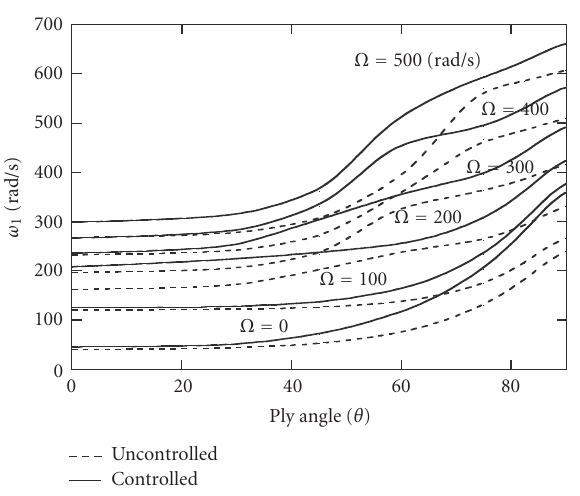
Figure 13: Variation of the first coupled open/closed flapping- lagging frequency versus ply angle for selected rotating speeds with the piezoelectrically induced bending moment ( K y = K x = 0 . 025, γ = β = 0).